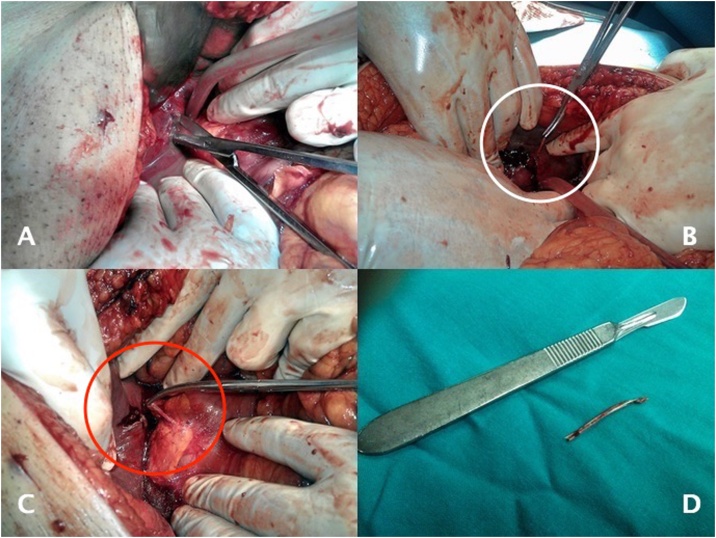
Surgical drainage and fishbone removal. A) Abscess drainage. B) Foreign body removal from inside the liver. C) Fibrous path coming from the pylorus. D) Fishbone with 3.8 cm.